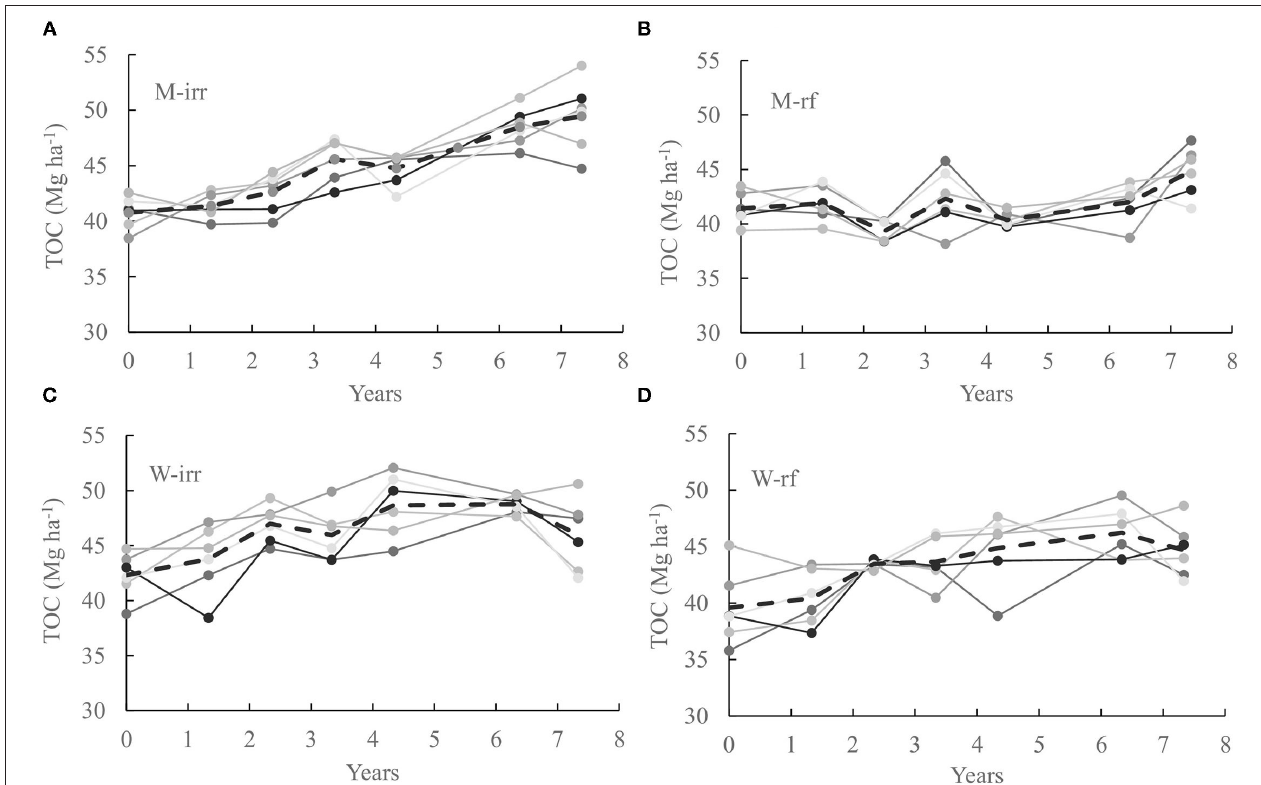
FIGURE 4 | Total organic C (TOC) stocks (Mg ha − 1 ) in the six plots per crop-irrigation combination, and average values over time (dashed line). M-irr, maize, irrigated (A) ; M-rf, maize, rainfed (B) ; W-irr, wheat, irrigated (C) ; W-rf, wheat, rainfed (D)